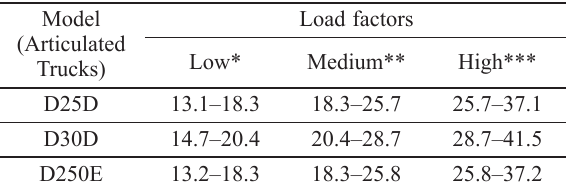
Table 3. Fuel consumption of articulated trucks according to